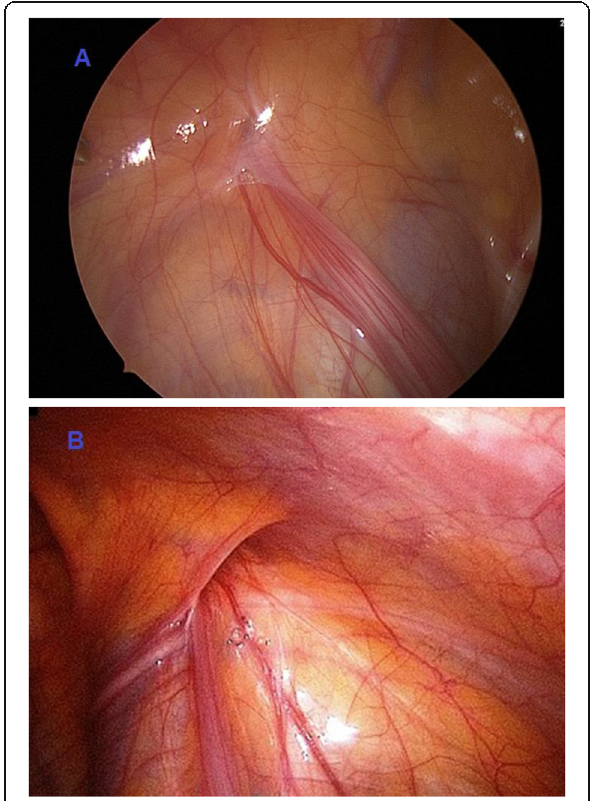
Fig. 12 a Congenital absence of the vas deferens. b Vas deferens is present on the right side for